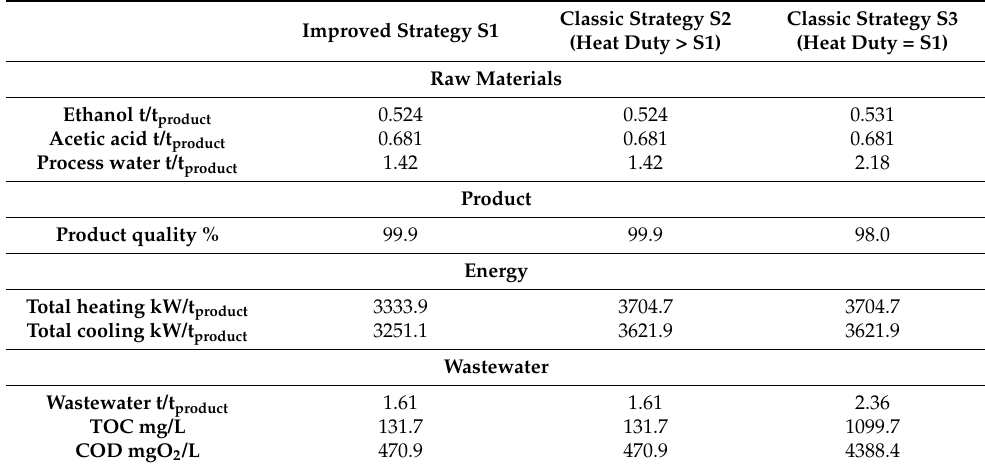
Table 2. Comparison of process indicators for the improved and typical process